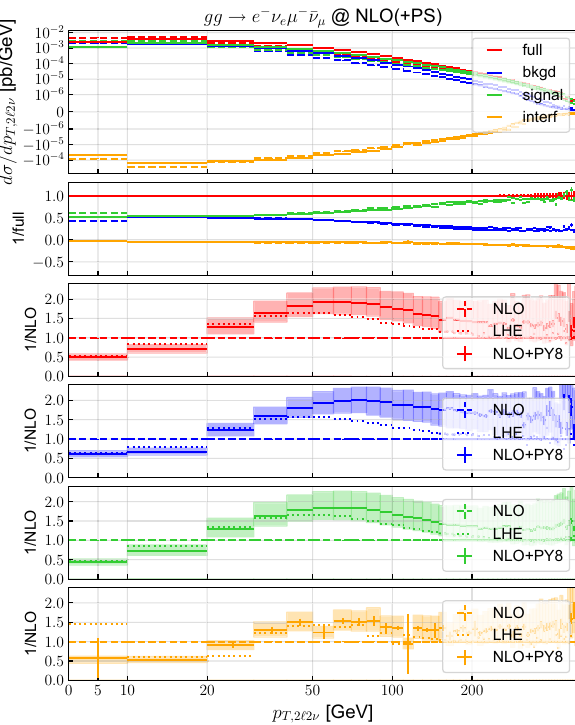
Fig. 10 Differential distribution in the transverse momentum of the hardest jet p T , j in gg → e + ν e μ − ¯ ν μ at NLO matched to PYTHIA 8 . 1 Predictions, colour coding and bands as in Fig.